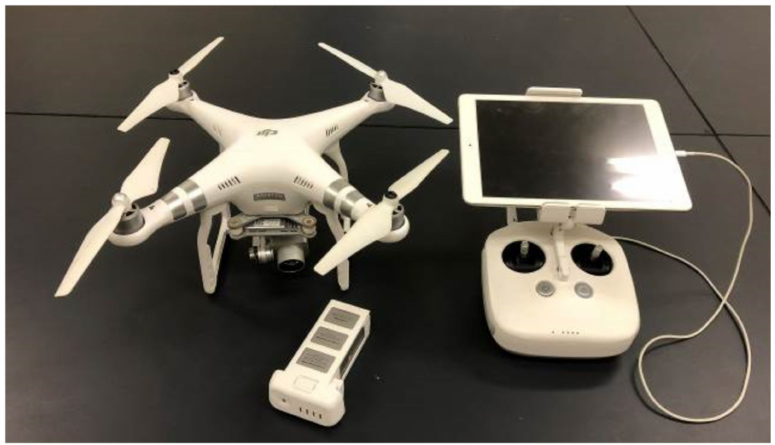
Figure 2. Phantom3 Advanced unmanned aerial vehicle (UAV, or drone). Source [49]. Table 1 lists the flight conditions and aerial imaging conditions for the UAV. The flight